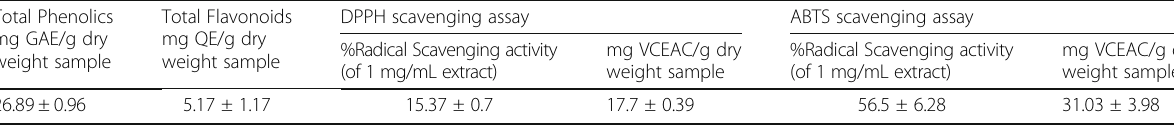
Table 1 Total phenolic content, total flavonoid content and free radical scavenging capacity of